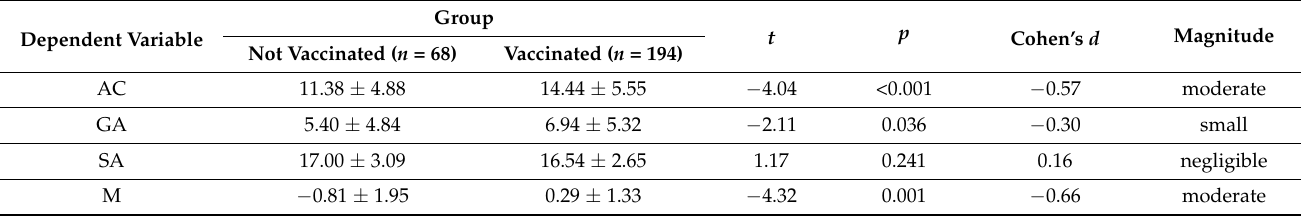
Table 4. Student’s t -tests results between vaccinated and non-vaccinated